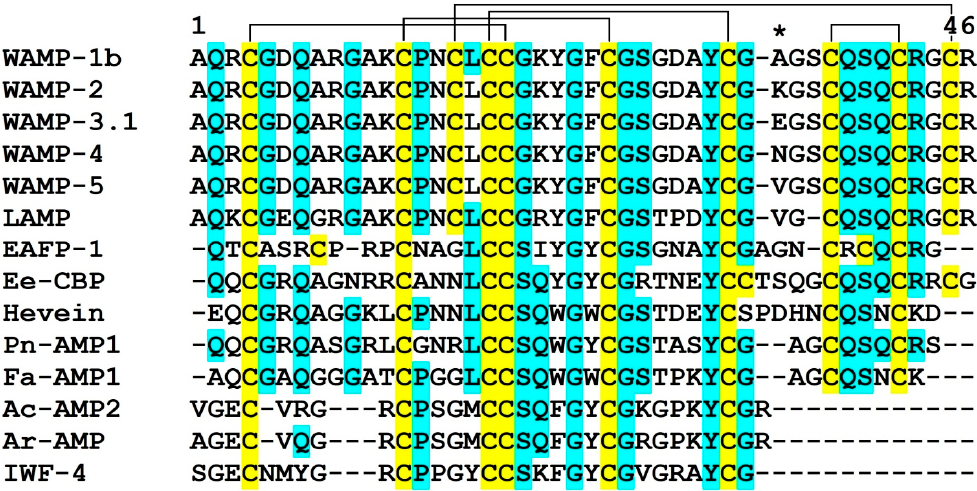
Figure 1. Amino acid sequences of WAMPs and selected hevein-like peptides: WAMP-1b (H6S4F1), WAMP-2 [17], WAMP-3.1 [17], WAMP-4 [17], WAMP-5 [19], LAMP (P86521), EAFP1 (P83596),